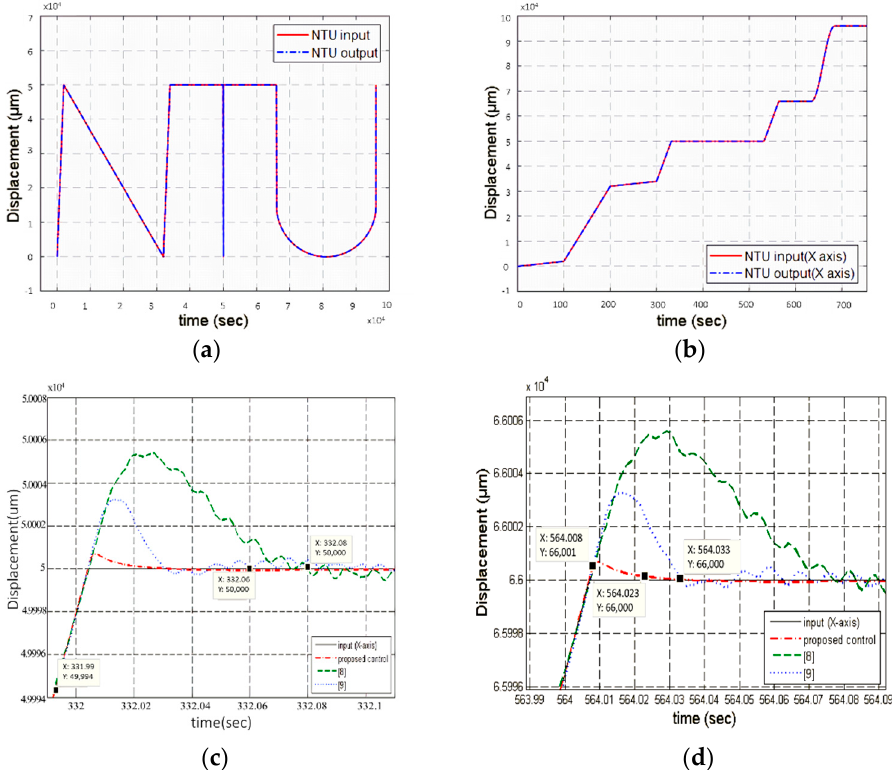
Figure 10. Experimental responses for tracking characters.: ( a ) character tracking; ( b ) x-axis responses; ( c ) zoom-in responses at the turning point around 332 sec; ( d ) zoom-in responses at the turning point around 564 sec.